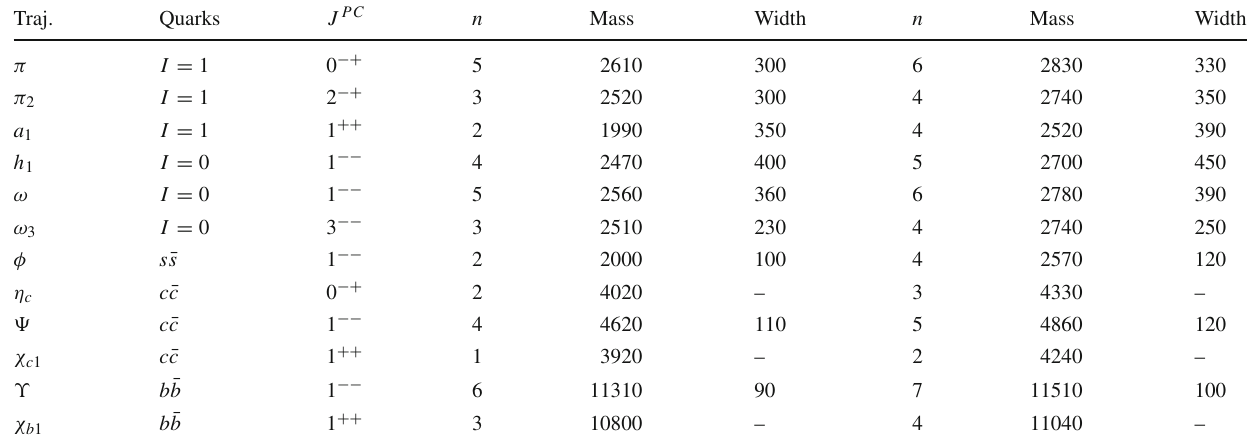
Table 2 Predictions for the next states in the ( n , M 2 ) plane for flavor- less mesons. Note that in our convention trajectories start from n = 0. Widths are determined using the fitting model of [6], although there